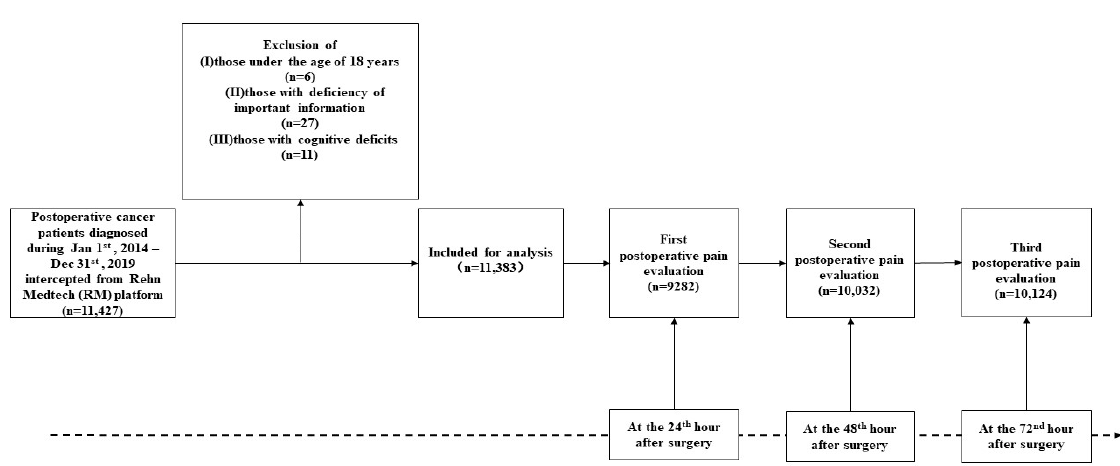
Figure 1. Flow diagram of study